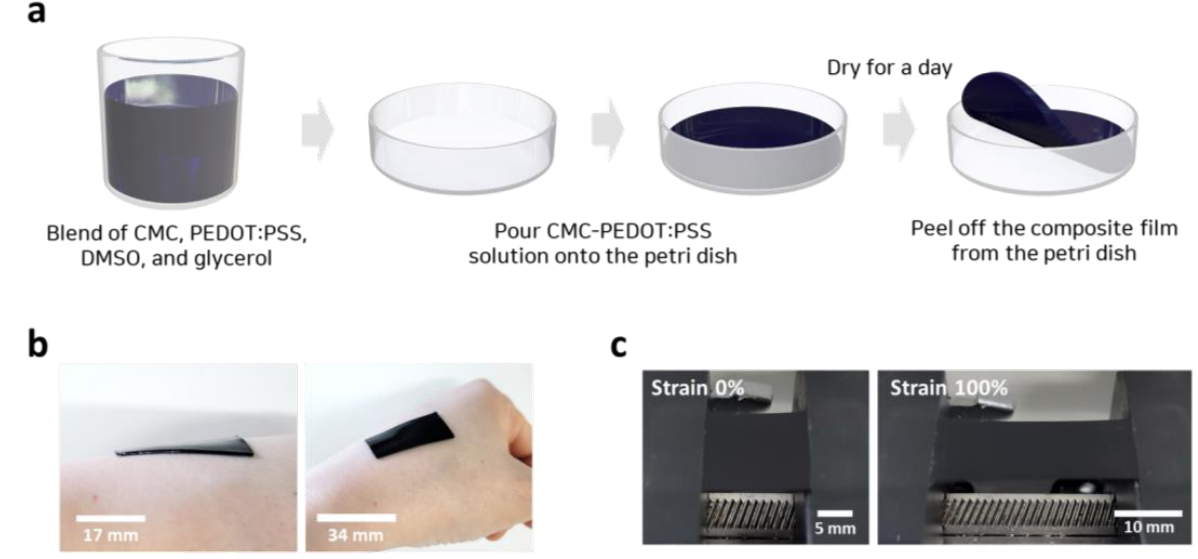
Figure 1. ( a ) Schematic of fabrication process for CMC-PEDOT:PSS composite films. ( b ) Photographs of CMC-PEDOT:PSS film attached to human skin. ( c ) Photographs of CMC-PEDOT:PSS films under strains of 0% and 100%.